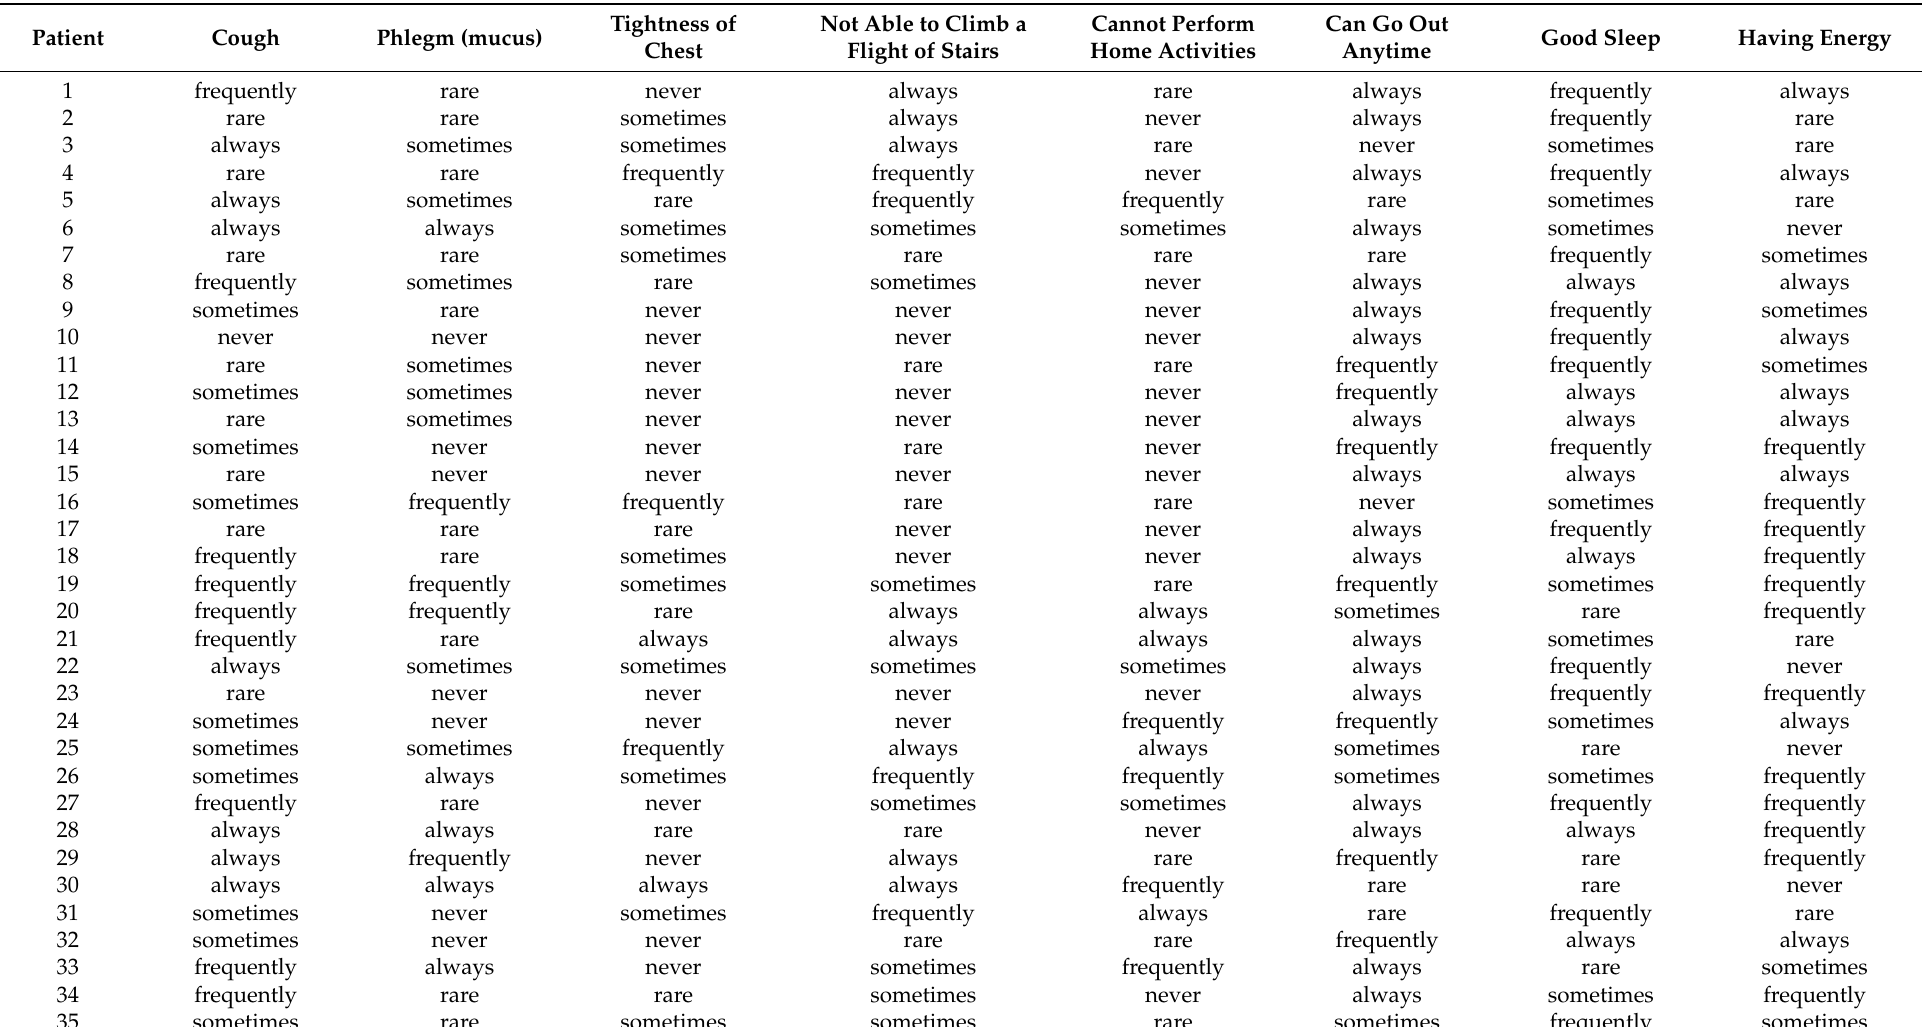
Table A2. Summary of CAGE (cut-annoyed-guilty-eye)